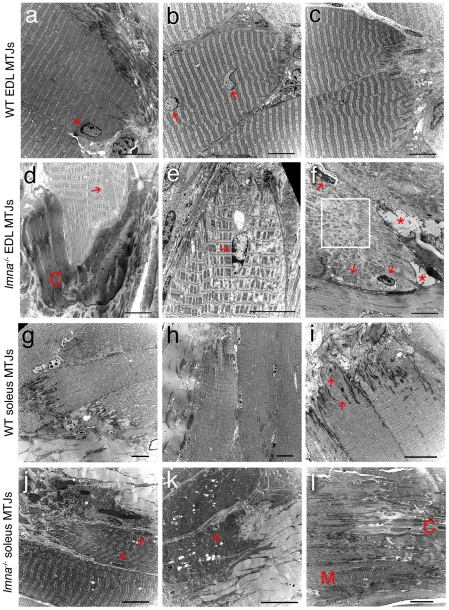
Myotendinous junction structure is abnormal in lmna−/− mice.Representative TEM images of longitudinal sections of myotendinous junction (MTJ) from EDL (a–c) and soleus (g–i) myofibres of wild-type (WT) lmna+/+ mice. Myonuclei (red arrows) and sarcomere organisation appear normal. Note the extensive inter-digitations between the myofibre and tendon. TEM images of longitudinal sections of myotendinous junctions from EDL (d–f) and soleus (j–l) myofibres from lmna
−/− mice. Myonuclei with abnormal shape, size and chromatin organization are evident (red arrows). There is a lack of inter-digitations, abnormal connective tissue (C in panel d) and fat accumulations (asterix in panel f) and sarcomeric disorganisation (boxed area in panel f). Myotendinous junctions in soleus muscle are particularly badly affected (j–l). The tissue architecture in (l) is so disrupted that the muscle region (M) and the connective tissue region (C) are barely distinguishable. Scale bar in each image equals 10 µm.